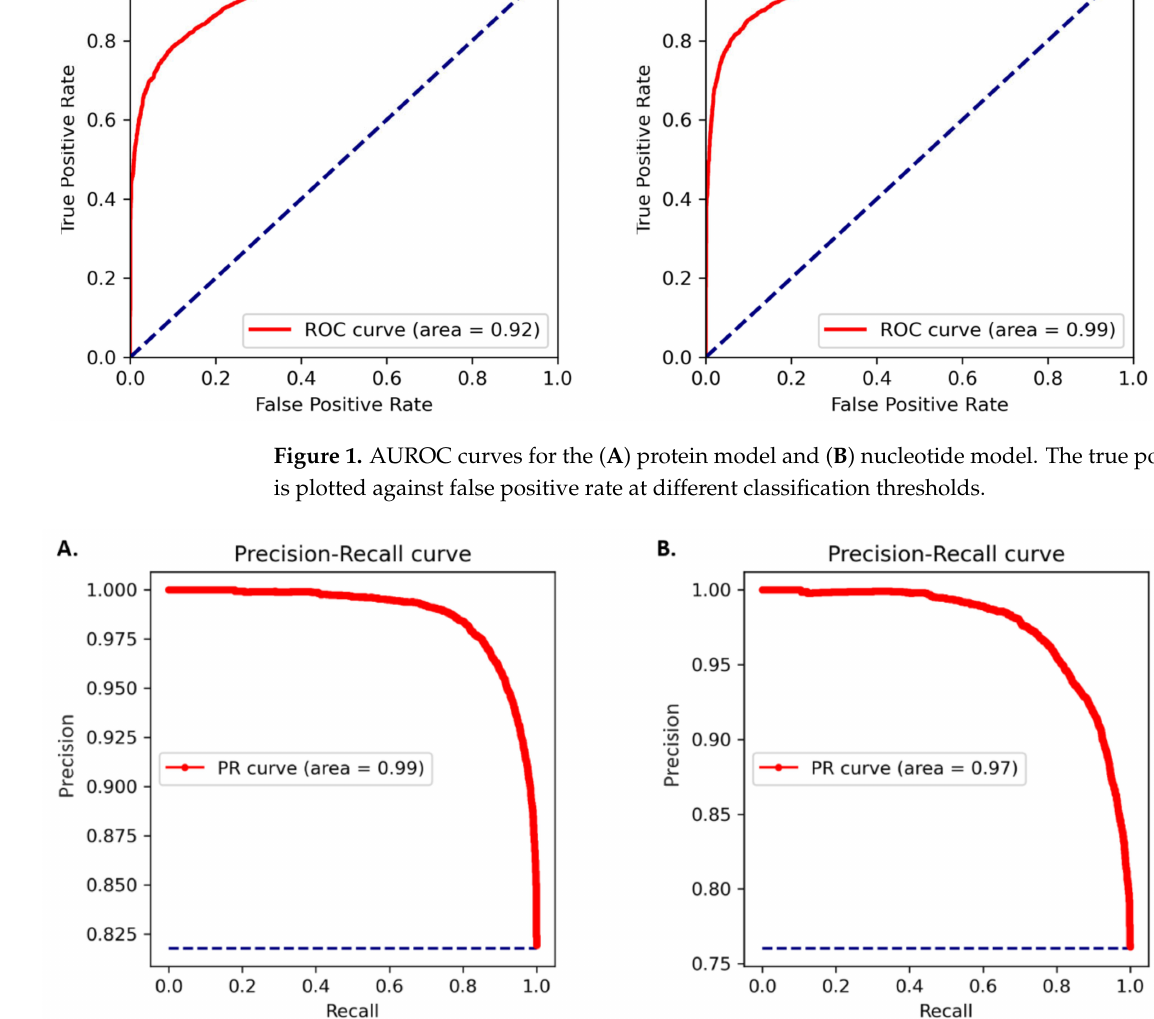
Figure 2. PR curves for ( A ) protein model ( B ) nucleotide model. Precision is plotted against recall at different probability